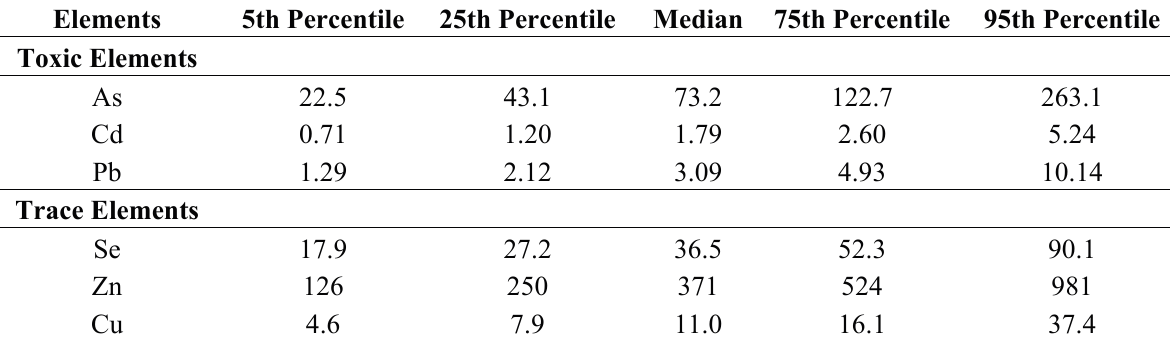
Table 3. Toxic and essential trace element concentrations ( μ